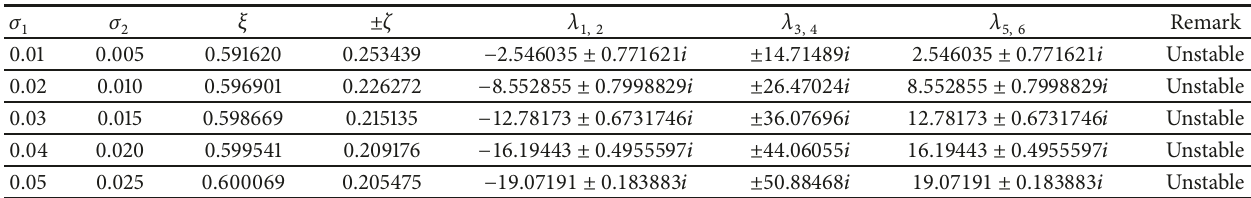
Table 4: Effects of triaxiality of PSR 1903+0327 on the locations and stability of out-of-plane points for 𝑎 = 0.95, 𝑒 = 0.437 and 𝐴 = 0.02 . 𝜎 1